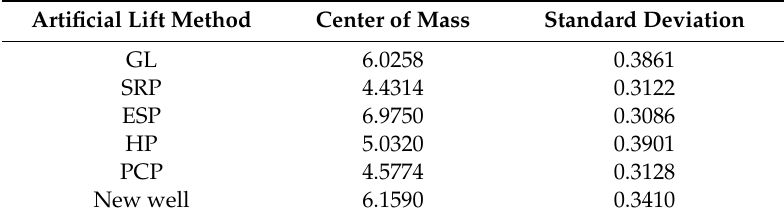
Figure 8. Model sensitivity −10% and +10% change.